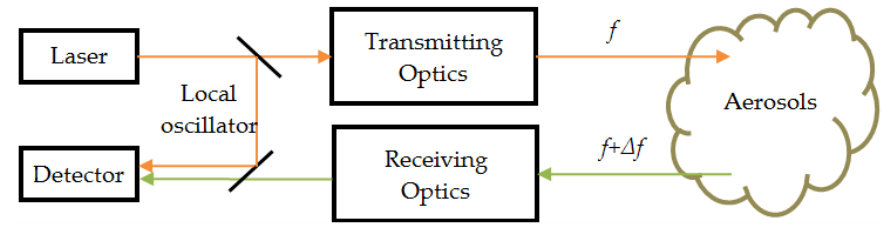
Figure 1. Schematic of the coherent Doppler wind Lidar.